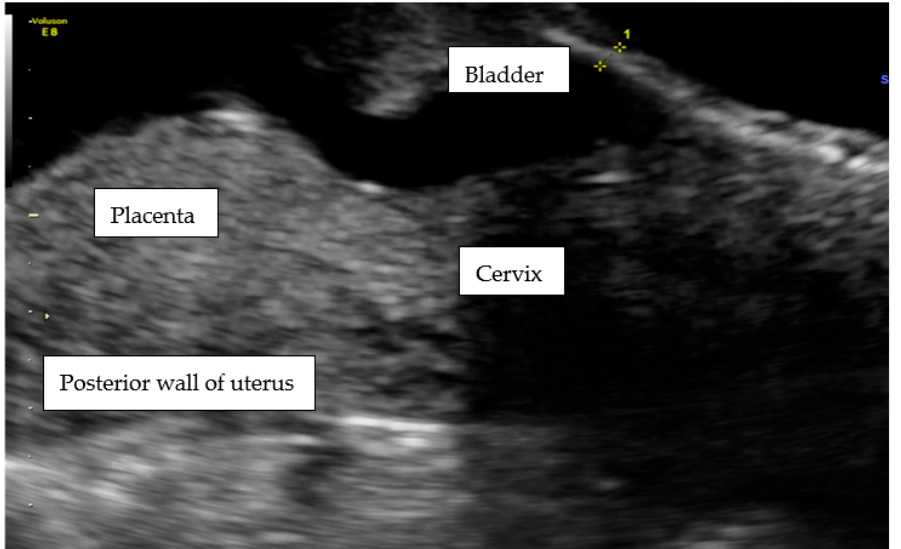
Figure 9. The transabdominal scan at 25 wks with measurement of scar thickness of 2.6 mm.